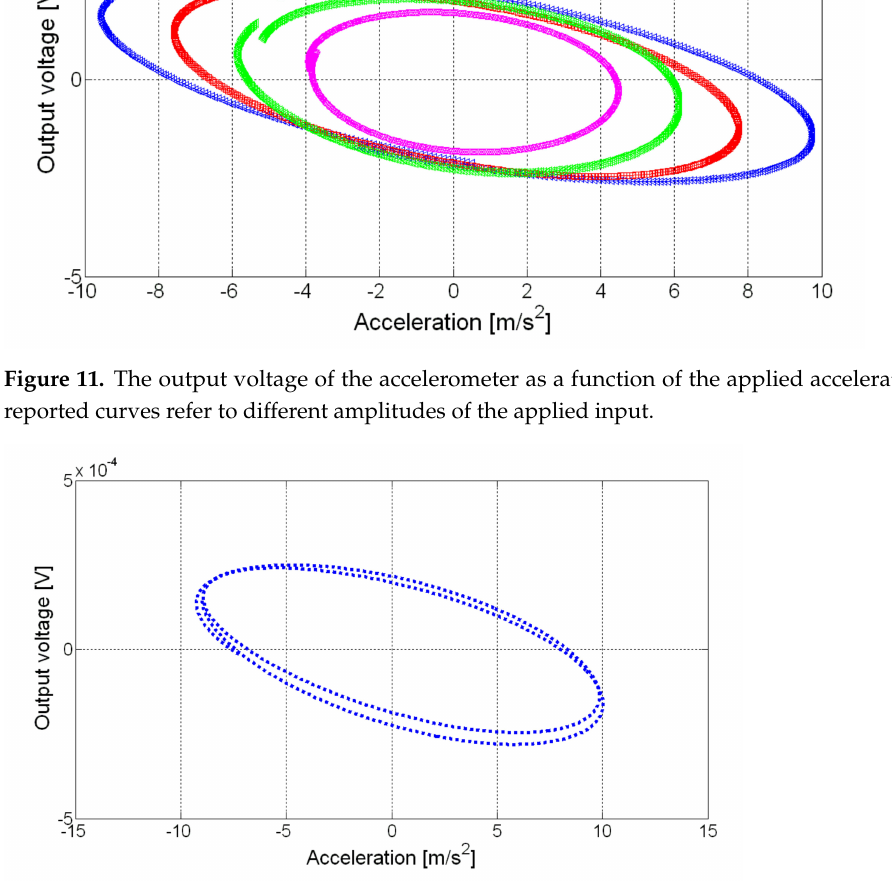
Figure 12. The output of the accelerometer as a function of an acceleration input, with a peak-to-peak amplitude equal to about 20 m/s 2 . The graph includes some periods of the input source and outlines the presence of low-frequency